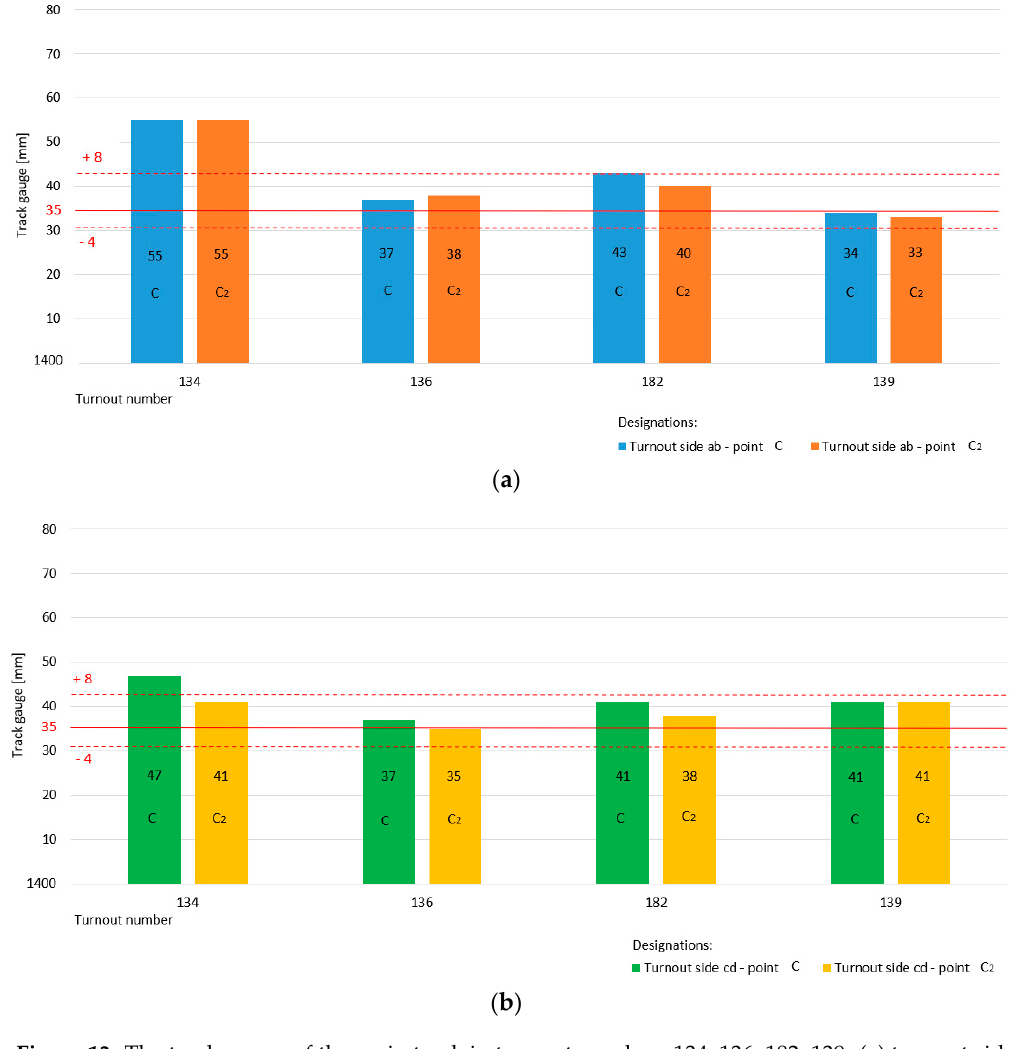
Figure 13. The track gauge of the main track in turnout numbers 134, 136, 182, 139: ( a ) turnout side “ab” (measurement at c, c 2 ); ( b ) turnout side “cd” (measurement at c, c 2 ).